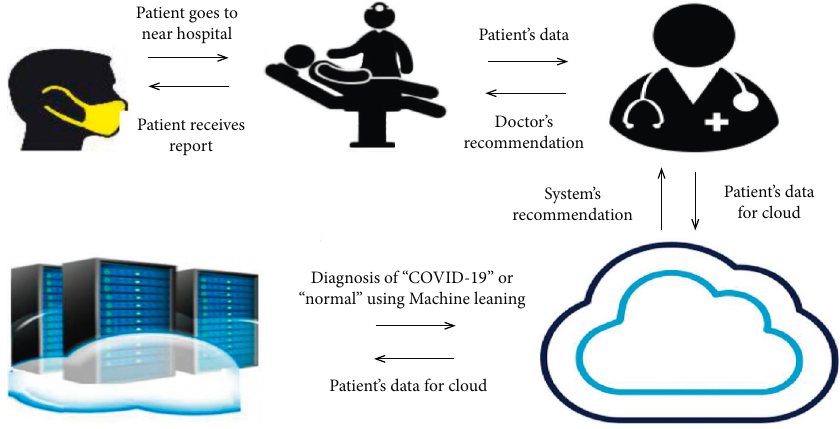
Figure 1: Proposed research